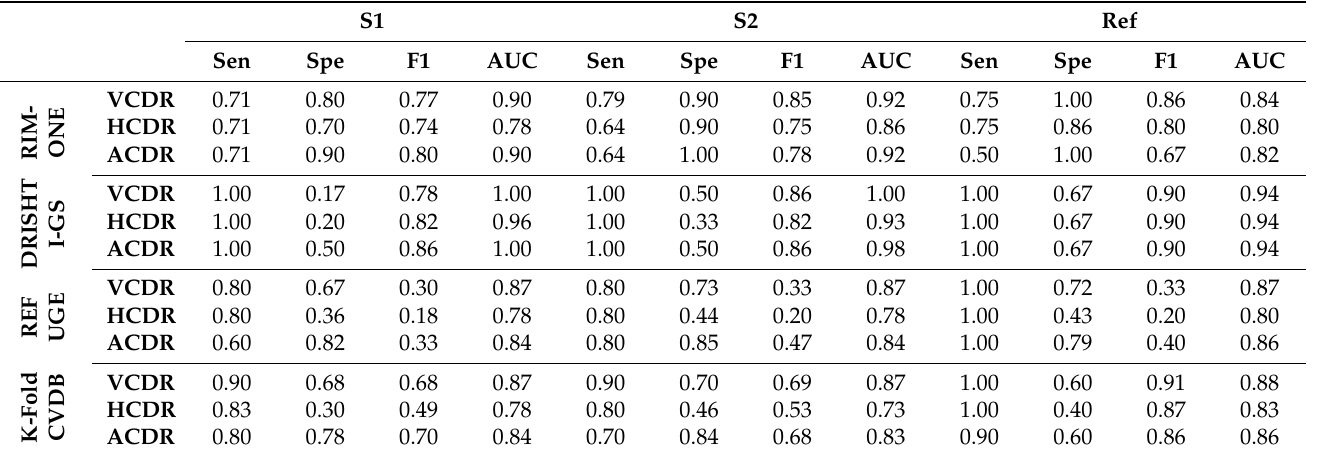
Table 7. Results of glaucoma classification with CDR calculations for S1, S2 and Ref